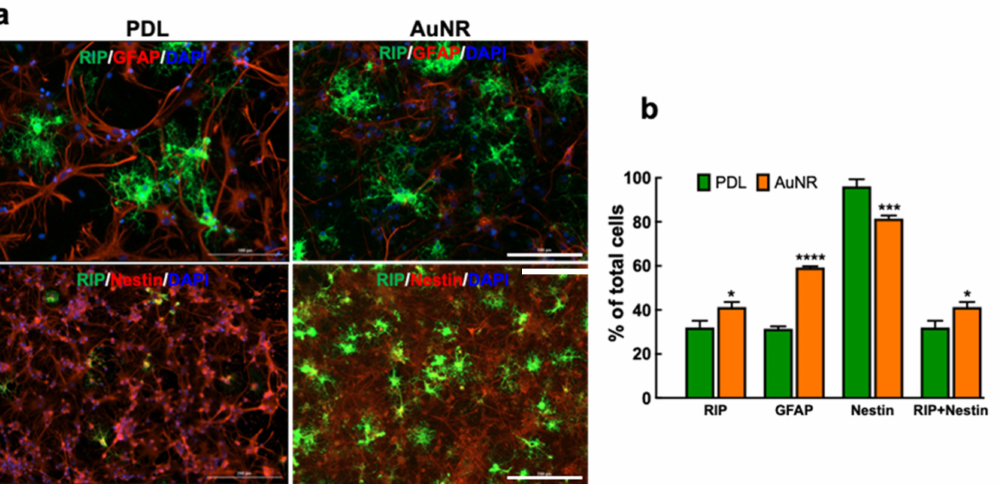
Figure 4. In vitro differentiation of NPCs into ODCs on PDL and AuNR substrate at week 1. ( a ) Im- munostaining of NPCs with markers for oligodendrocyte (RIP, green), astrocyte (GFAP, red), interme- diate filament protein (nestin, red), and nuclear stain (DAPI, blue). Scale bars: 100 µ m (top), 200 µ m (bottom). ( b ) Quantitative comparison of the percentage of cells expressing RIP, GFAP, and nestin on PDL and AuNR. Data show mean ± SD; comparison by one-way ANOVA with Tukey post hoc analysis; * p < 0.05, *** p < 0.001, **** p < 0.0001 compared to the same cell type on PDL